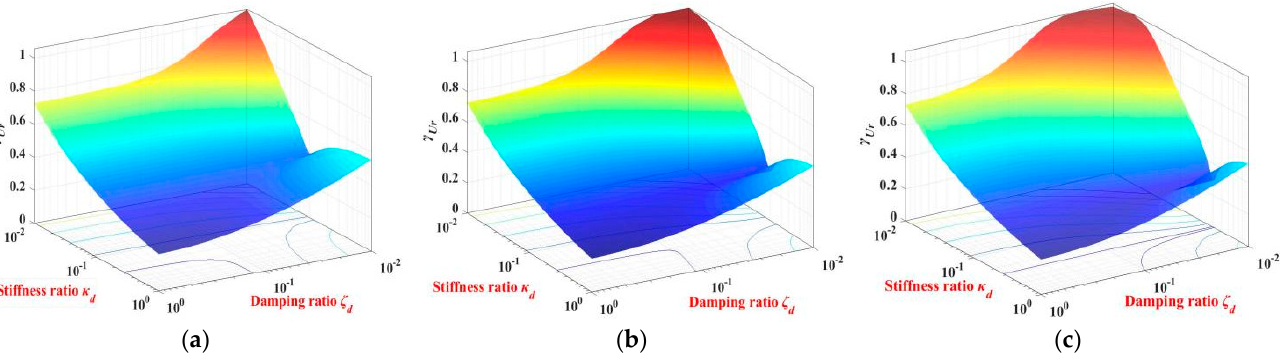
Figure 6. Contour plot of γ Ut of SC system: ( a ) μ d = 0.1; ( b ) μ d = 0.2; and ( c ) μ d = 0.3.